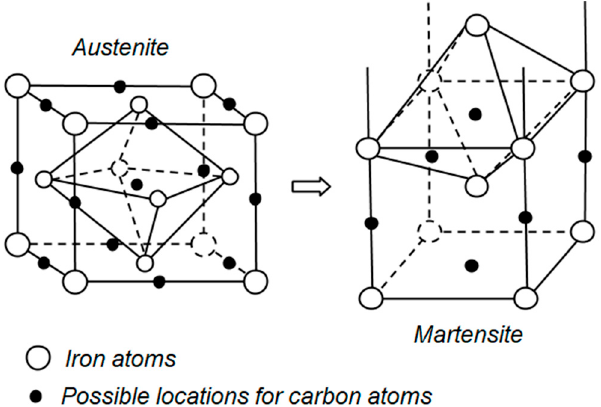
Figure 1. Transformation of soft retained austenite to relatively hard and stable martensite at lower temperature [30].